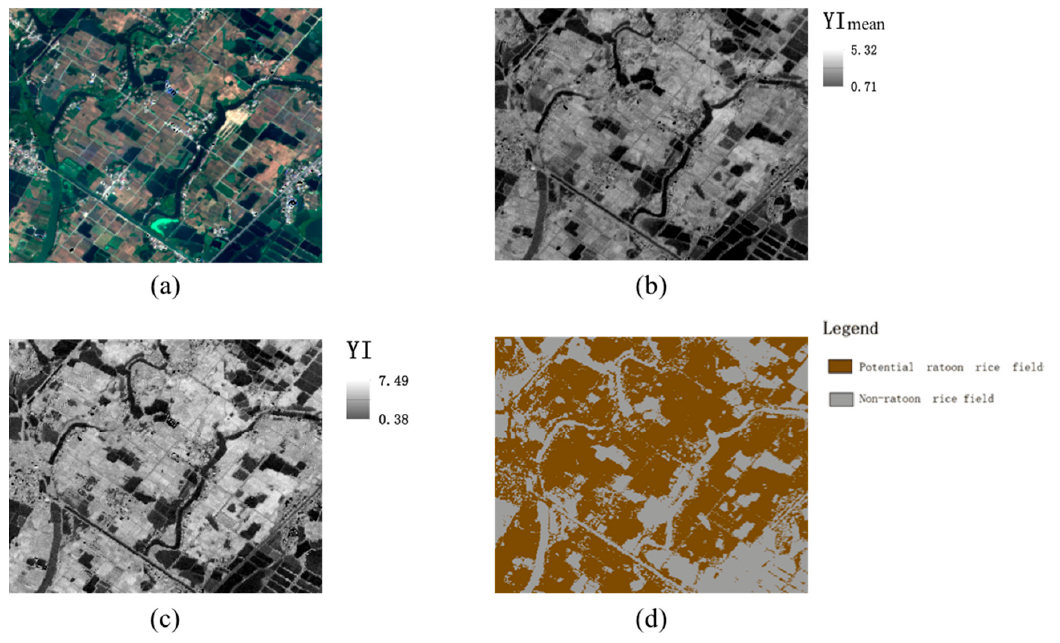
Figure 4. Images of a subset of cropland dominated by ratoon rice fields, including the true-color Sentinel-2A image ( a ), the YI mean image ( b ), the enhanced YI image ( c ), and the segmentation of potential RR fields ( d ).